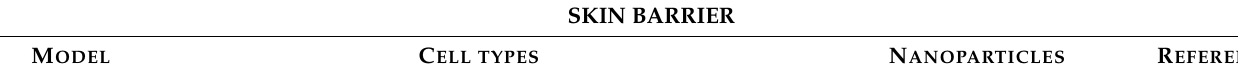
Table 6. Summary of in vitro skin barrier models used for nanomedical studies. SKIN